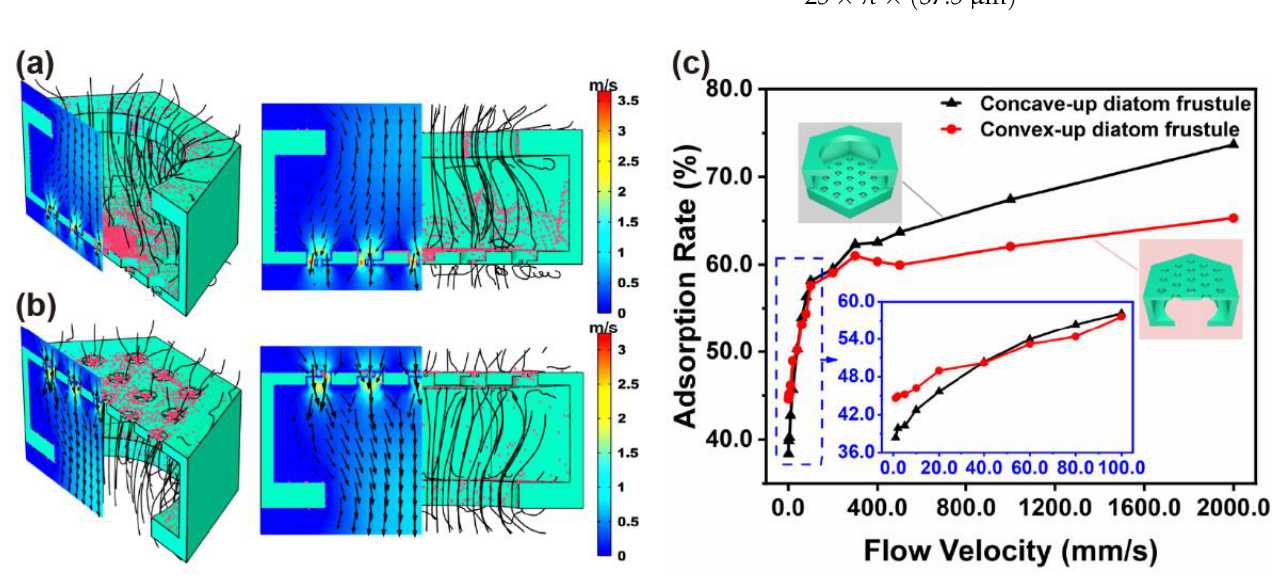
Figure 8. Simulation results of flow field in single-cell and nanoparticle distribution of cell surface for ( a ) concave-up frustules, ( b ) convex-up frustules, and ( c ) adsorption rate via flow velocity.